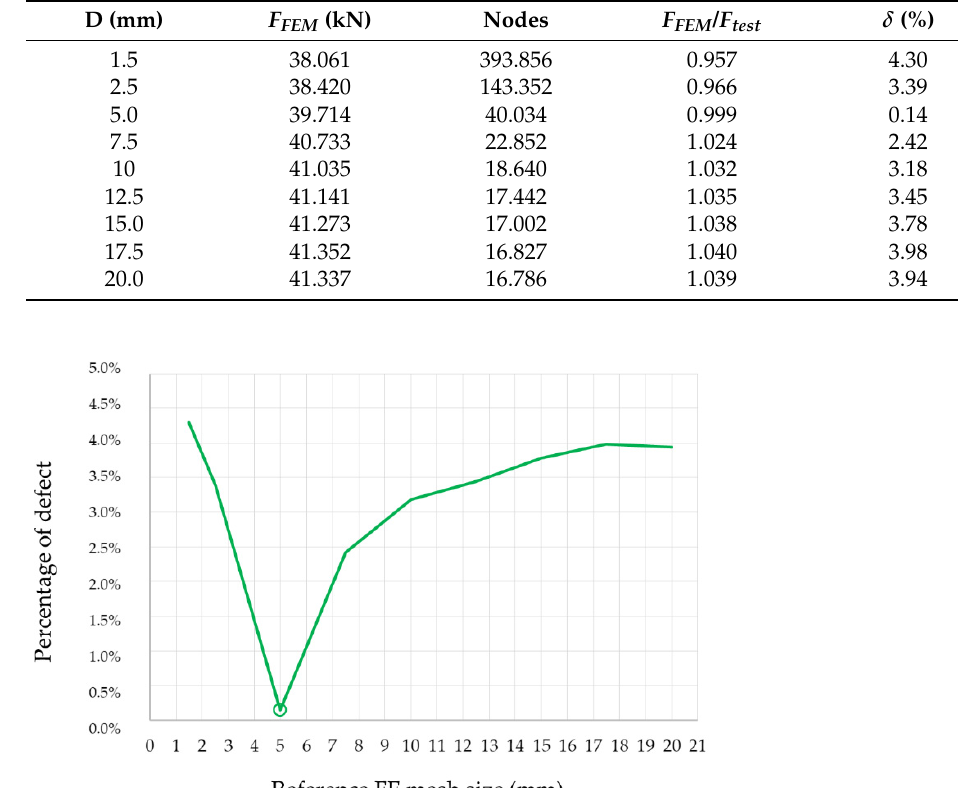
Table 3. Parameters of ES mesh optimisation.